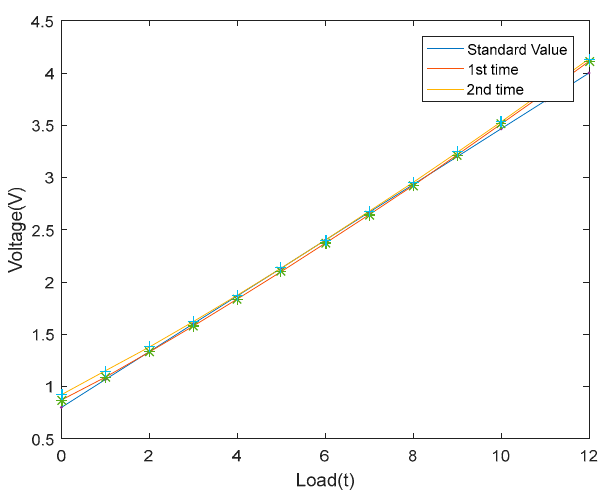
Figure 16. Linearity experiment results of the sensor.